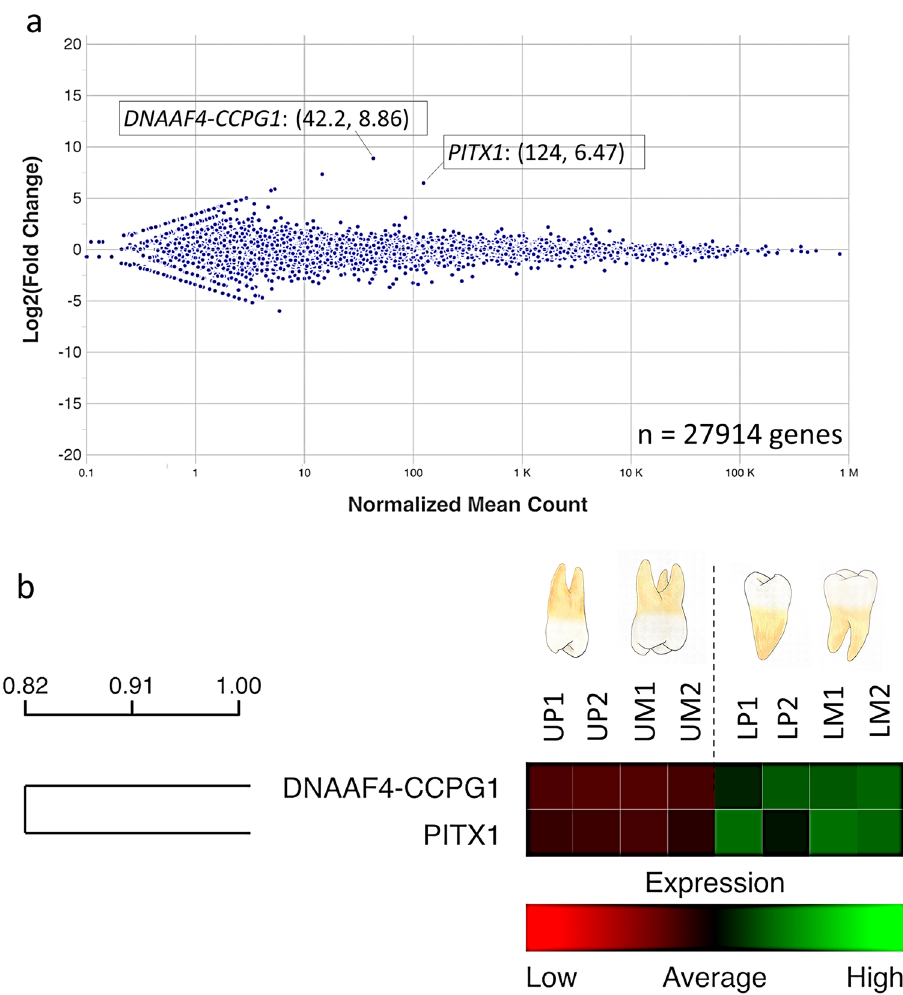
Figure 2. Differential gene expression between upper and lower posterior teeth (2 pairs of premolars + 2 pairs of molars). ( a ) MA-plot indicating the overall differential genes between the upper and lower posterior teeth. ( b ) Hierarchical cluster heat maps of differential expressed genes in 4 pairs of teeth reveal that two genes, PITX1 and DNAAF4-CCPG1 , had true significance and log2FC of ≤ − 2 or ≥ 2. One row in the heatmap represents one gene. The intensity of the color indicates the expression level, with green representing high expression level and red representing low expression